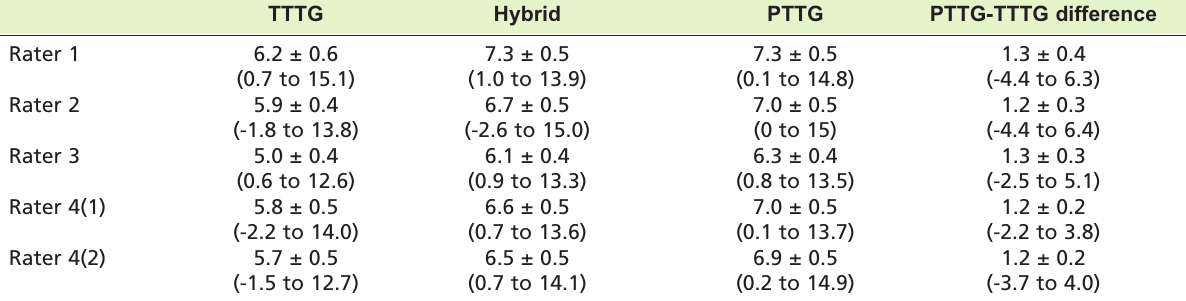
Mean TTTG, hybrid PTTG and PPTG distances for the non-PFI group for each rater Table I: